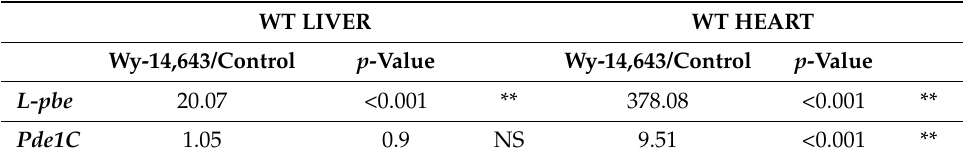
Table 1. Pde1C mRNA levels increase only in the hearts and not in the livers upon Wy-14,643 treatment of WT mice.